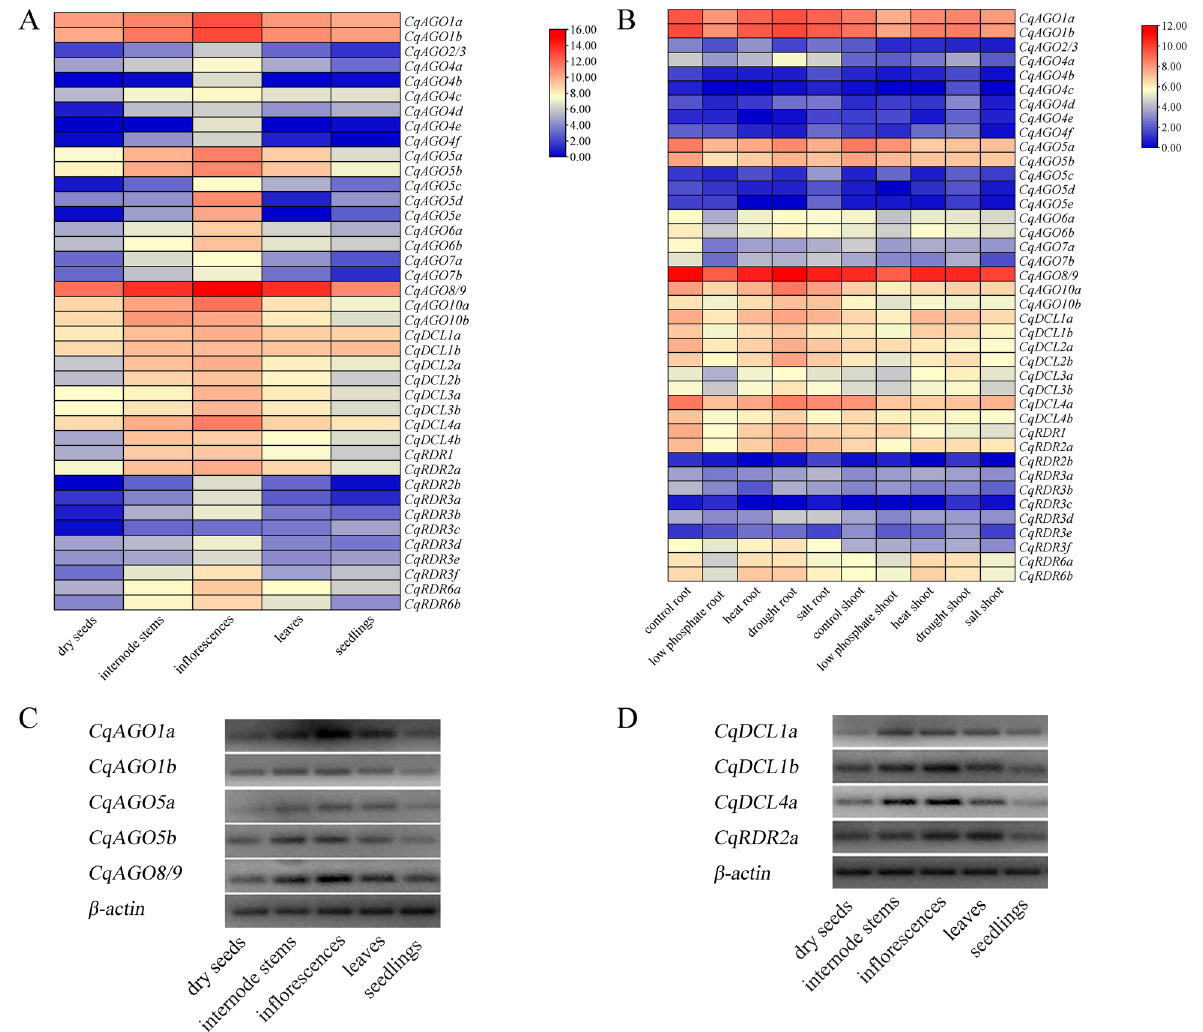
Figure 8. ( A ) Expression profiles of CqAGO s, CqDCL s, and CqRDR s in different tissues, including dry seeds; one-week-old seedlings; stems, leaves, and inflorescences of six-week-old plants. ( B ) Expression profiles of CqAGO s, CqDCL s, and CqRDR s under low-phosphate, heat, drought, and salt stresses in root and shoot, respectively. The log2 normalized value of original TPM data are represented in both figures. The colour bar at the right of the heat map represents relative expression values. Electrophoresis analysis in different tissues of CqAGOs ( C ) and CqDCLs , CqRDR ( D ). β-actin was used as a control for each tissue